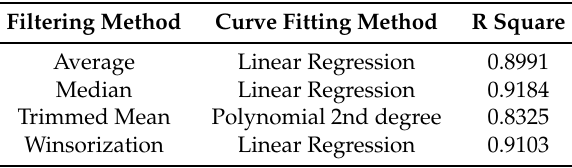
Table 6. RSSI to distance outdoor band 3.